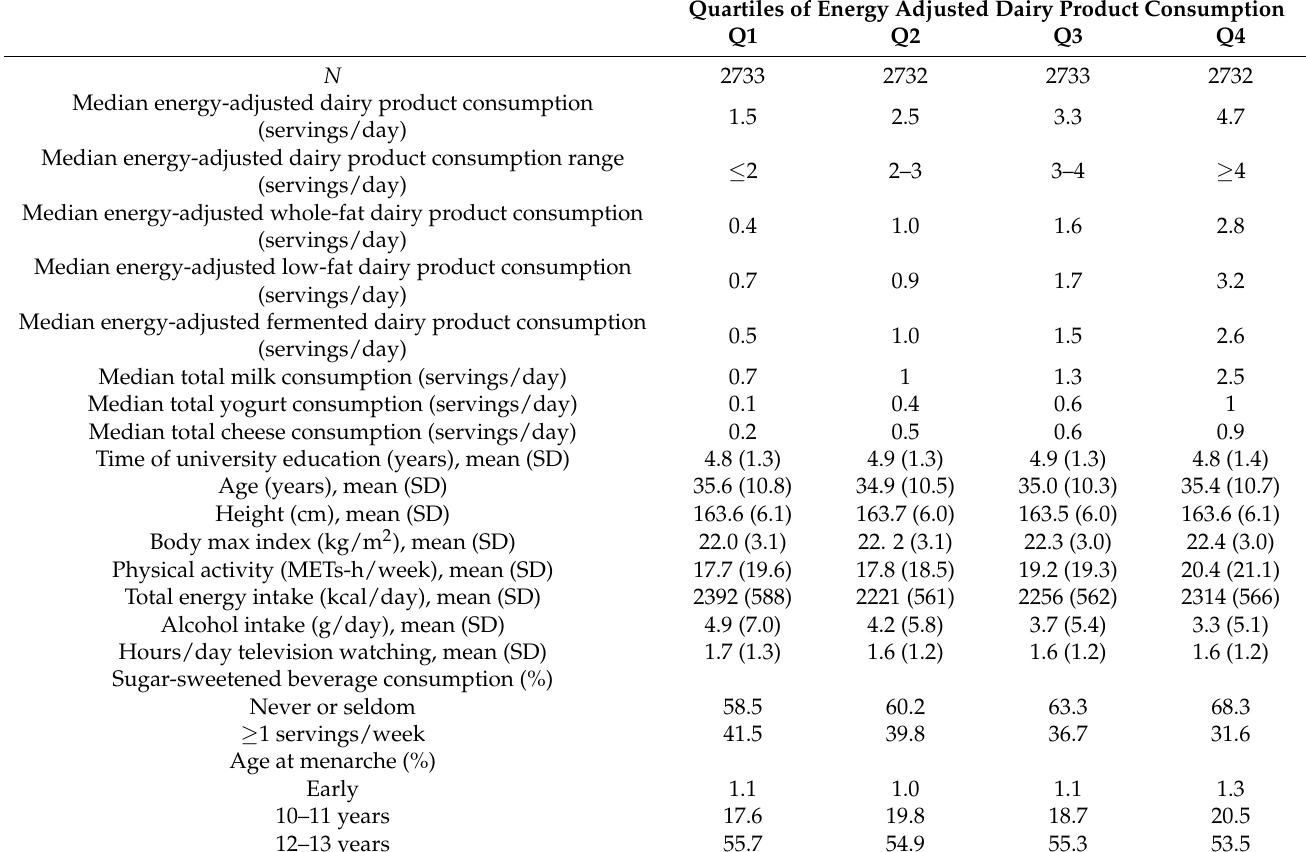
Table 1. Baseline characteristics of 10,930 women in the SUN cohort according to the baseline total dairy product consumption. Quartiles of Energy Adjusted Dairy Product